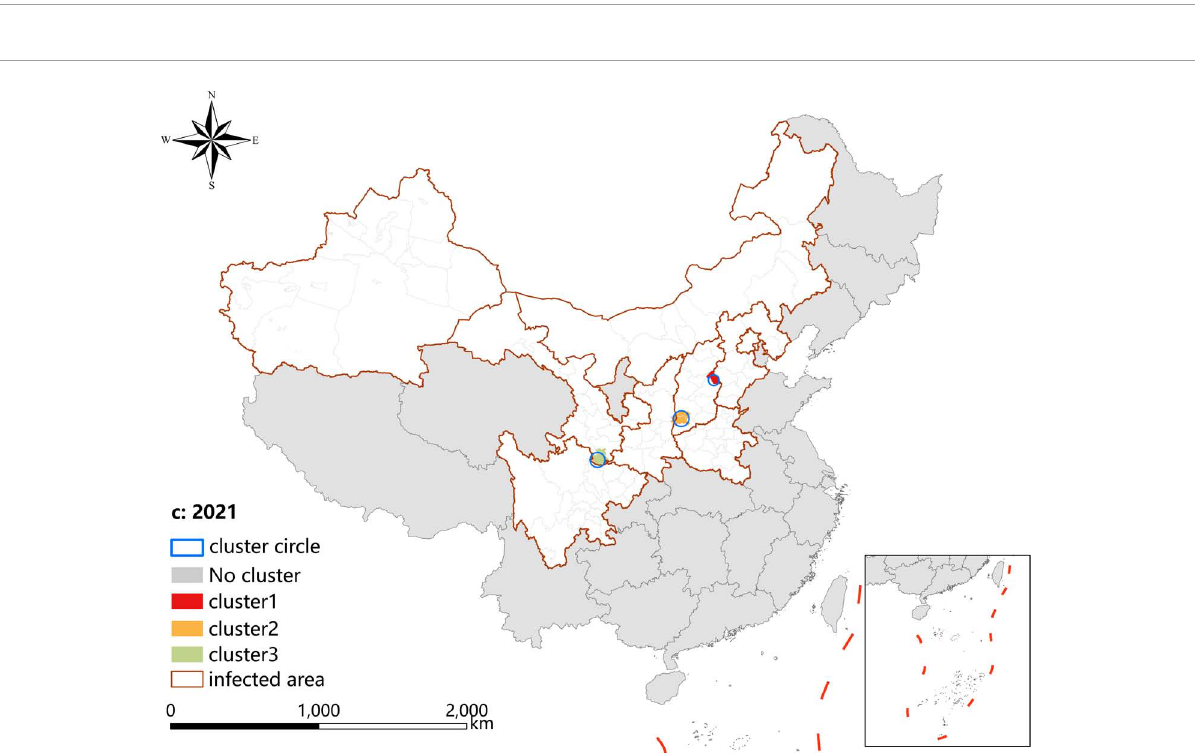
FIGURE8 Spatio-temporal clustering analysis of visceral leishmaniasis incidence in mainland China in